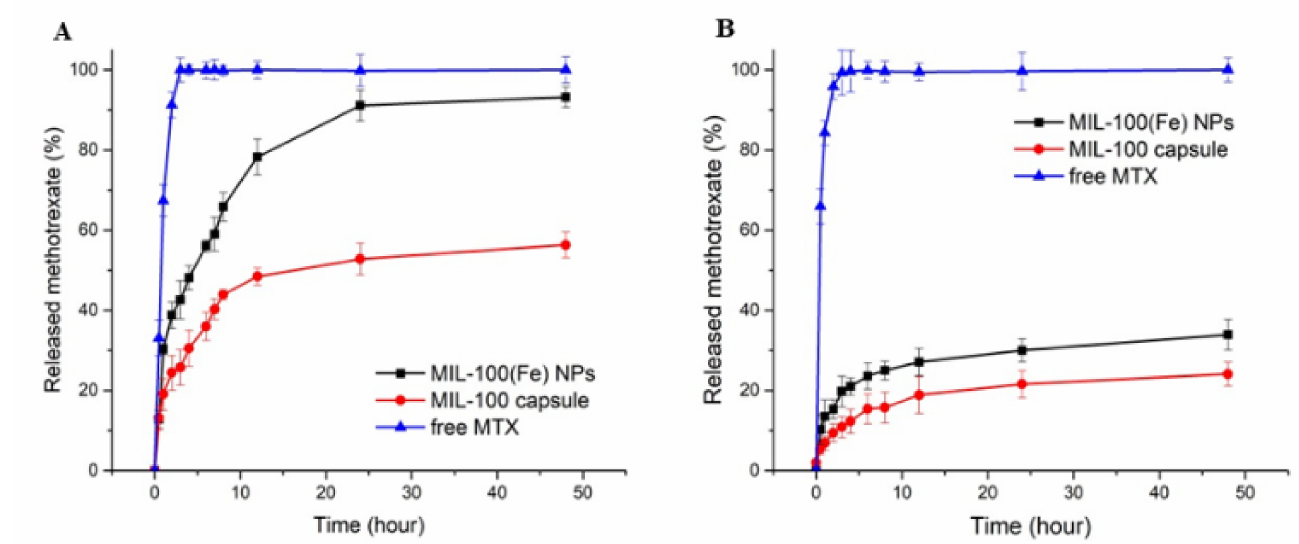
Figure 5. Release profiles of MTX at 37 ◦ C from MIL-100(Fe) NPs and MIL-100 capsules in PBS at pH 7.4 ( A ) and pH 5 ( B